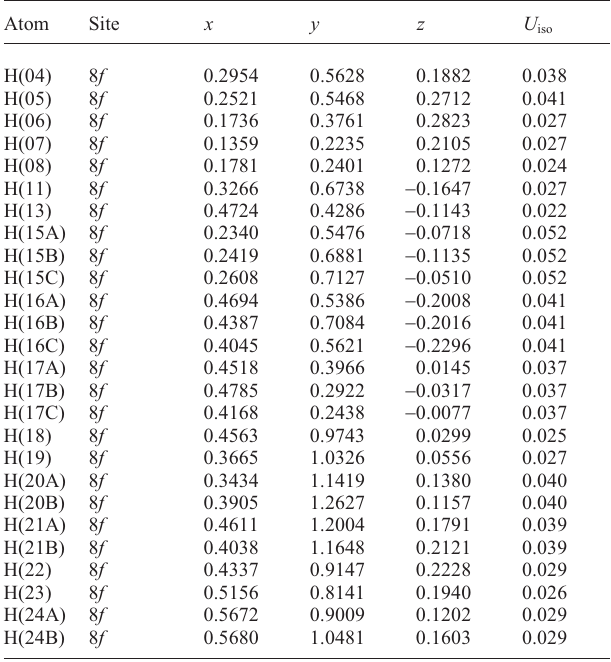
Table 2. Atomic coordinates and displacement parameters (in Å 2 )